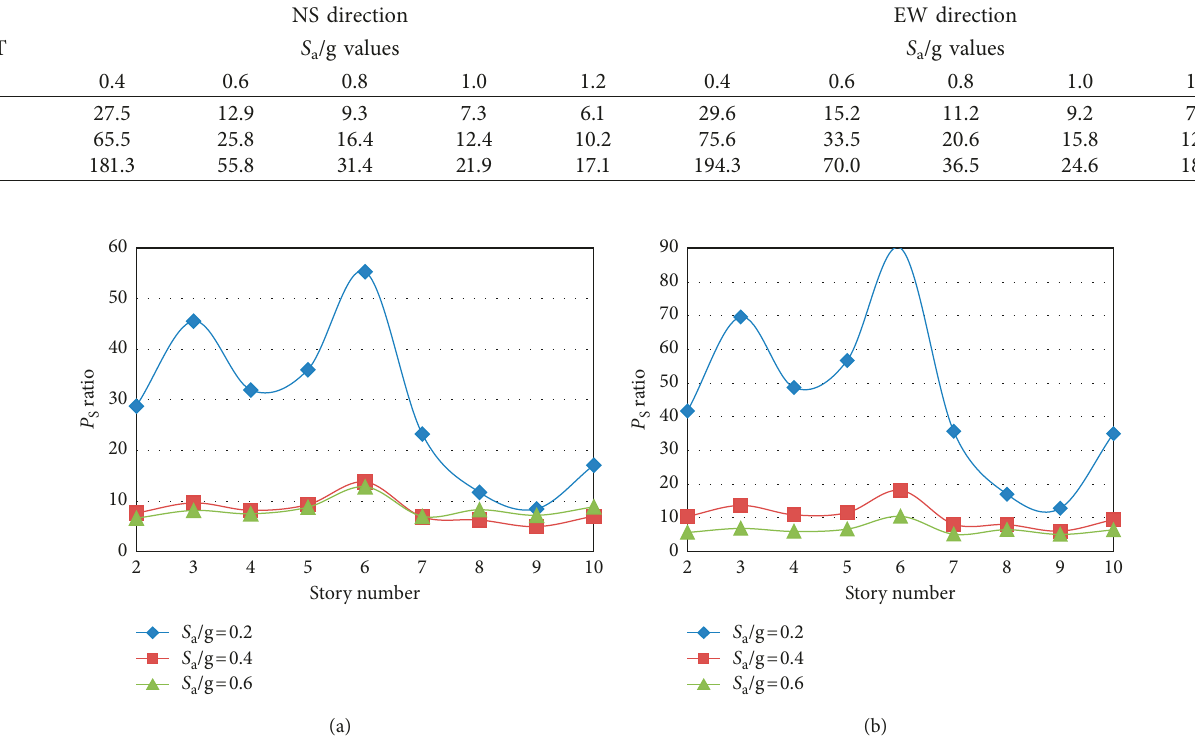
Figure 9: P S ratio, 10-level building: (a) NS direction; (b) EW